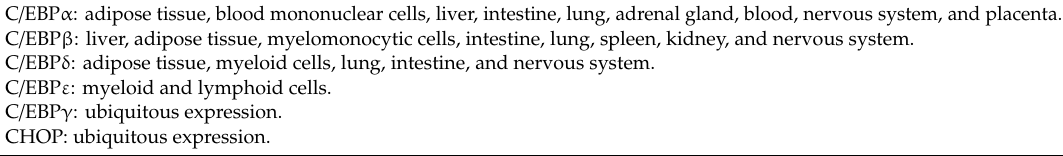
Figure 1. Structure of the C/EBP transcription factor family. Each member of this family of proteins share a high degree of sequence similarity at the C-terminus, including the leucine zipper domain and the basic region. At the N-terminus, the structures vary among different family members and among different isoforms. Table 1. Tissue distribution of the various members of the C/EBP family.